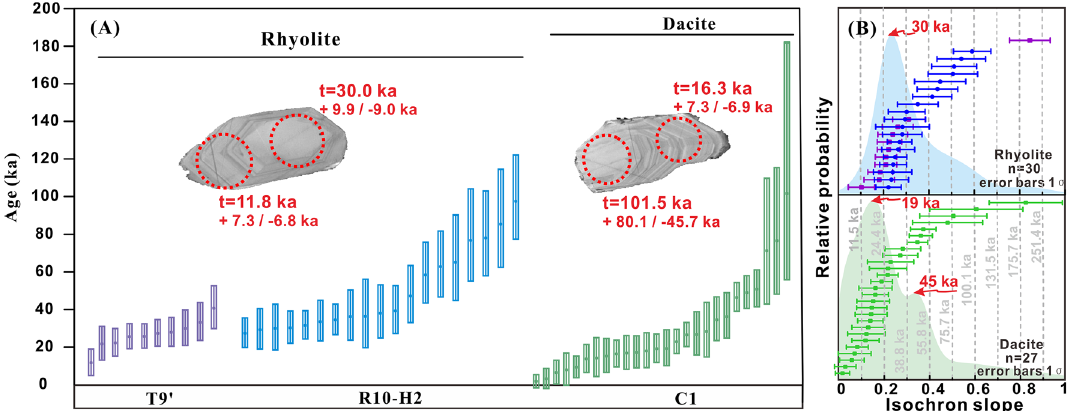
Figure 1. Zircon U–Th geochronology of the back-arc volcanic rocks. ( a ) CL images of two Light-CL zircons showing several microprobe analysis locations and their corresponding ages. ( b ) Cumulative PDF curves of the slopes of the 238 U– 230 Th model isochrons for the SIMS zircon data. The purple, blue, green and vertical dashed lines represent rhyolites T9’ and R10-H2, dacite C1, and the reference ages,